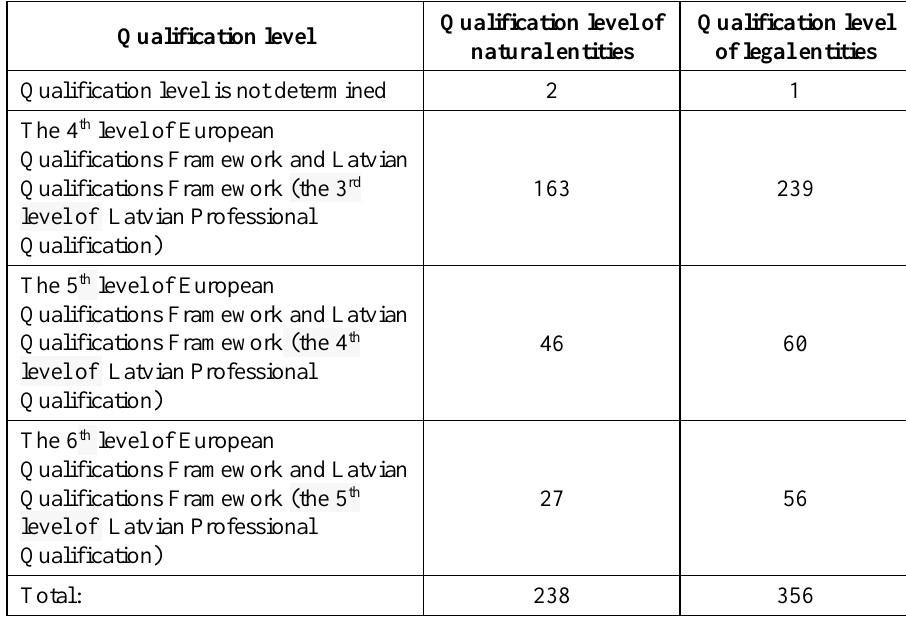
Table 3. The Qualification Level of Professional Administrators Included in the Register of Administrators of Residential Houses (Ministry of Economics,